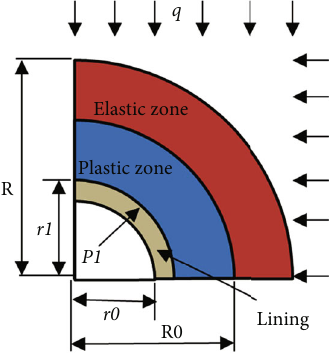
Figure 2: Elastoplastic analysis